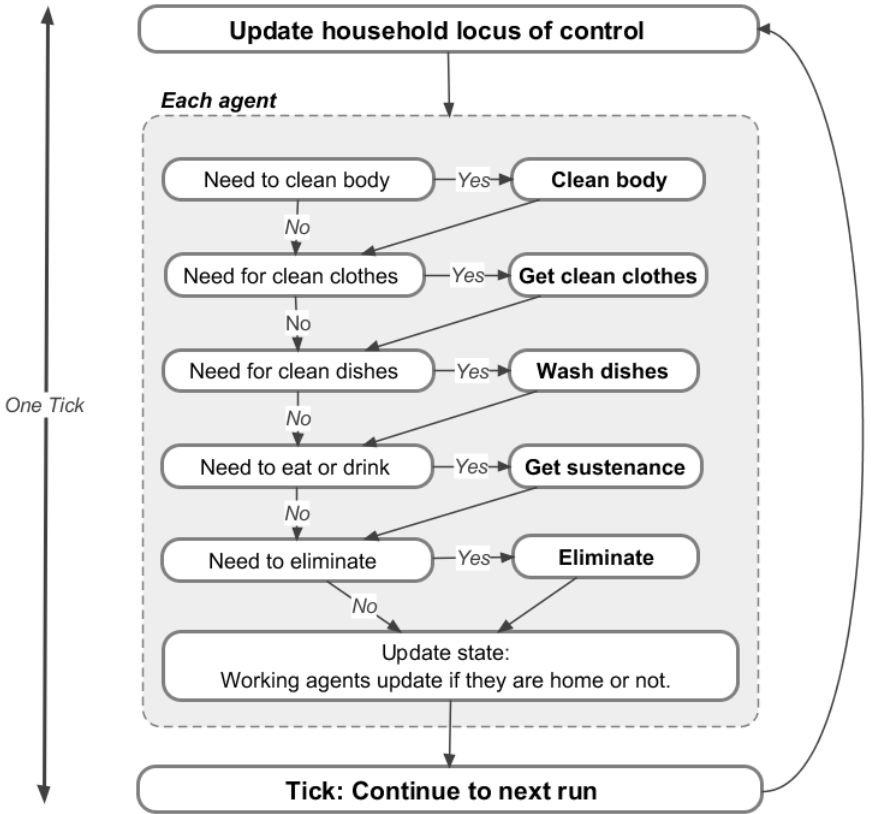
Figure 3. Agent action and general model processes scheduling during one time step of the model, which is one model tick. Agent actions and their order are listed in the grey